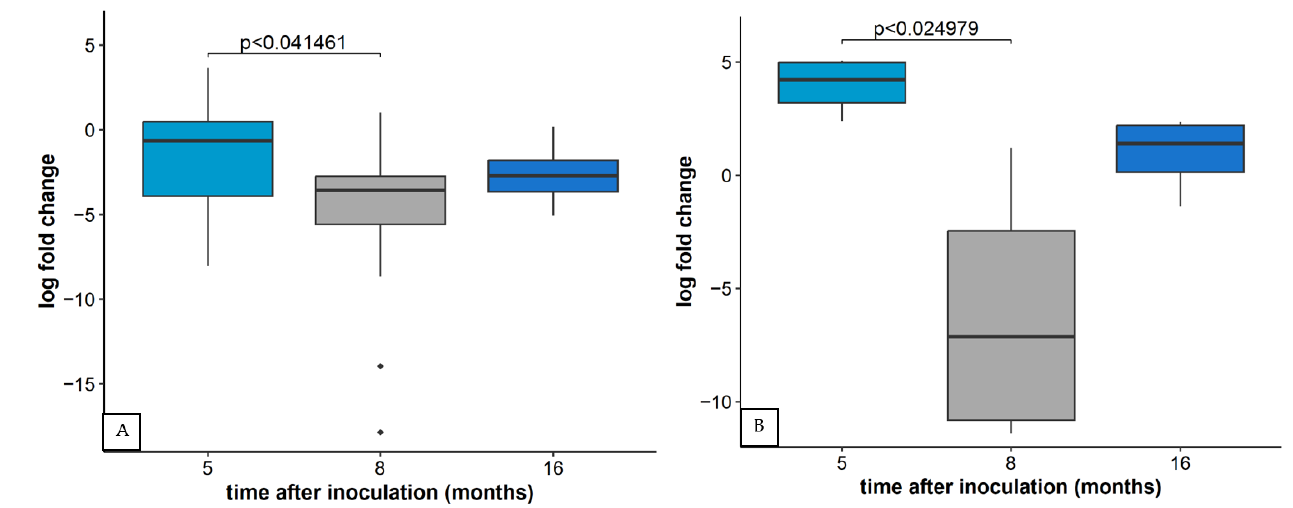
Figure 5. ( A ) The relative concentration of GPGV based on CP region and ( B ) GFkV based on CP region five, eight, and 16 months after inoculation observed in inoculated plants of all varieties. Results are displayed as logarithmic ratios of relative concentration. ANOVA test was performed along with the Bonferroni post hoc test and significantly different values ( p < 0.05) are marked over individual box plots. Outlier measurements that are 1.5 times over the upper/lower quartile of the dataset of an individual boxplot are marked with ◆ .